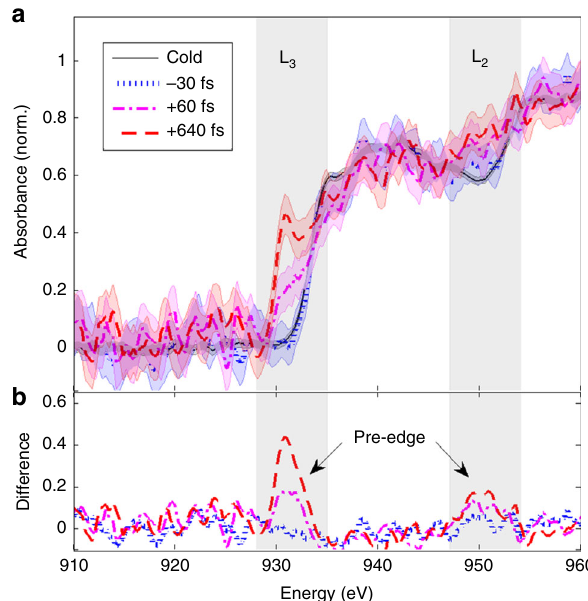
Fig. 3 Time-resolved XAS data. Selection of some measurements near the Cu L-edges (L 3 and L 2 ), without and with the pump pulse (incident fl uence of 1 J cm − 2 ), for three different X-ray probe delays. a Normalized X-ray absorbance. The shadowed area indicates the standard deviation of the measurements over a series of 50 consecutive shots. b Differential absorbance with respect to the curve without pump. Clear pre-edges appear a few eV below the L-edges just after the sample